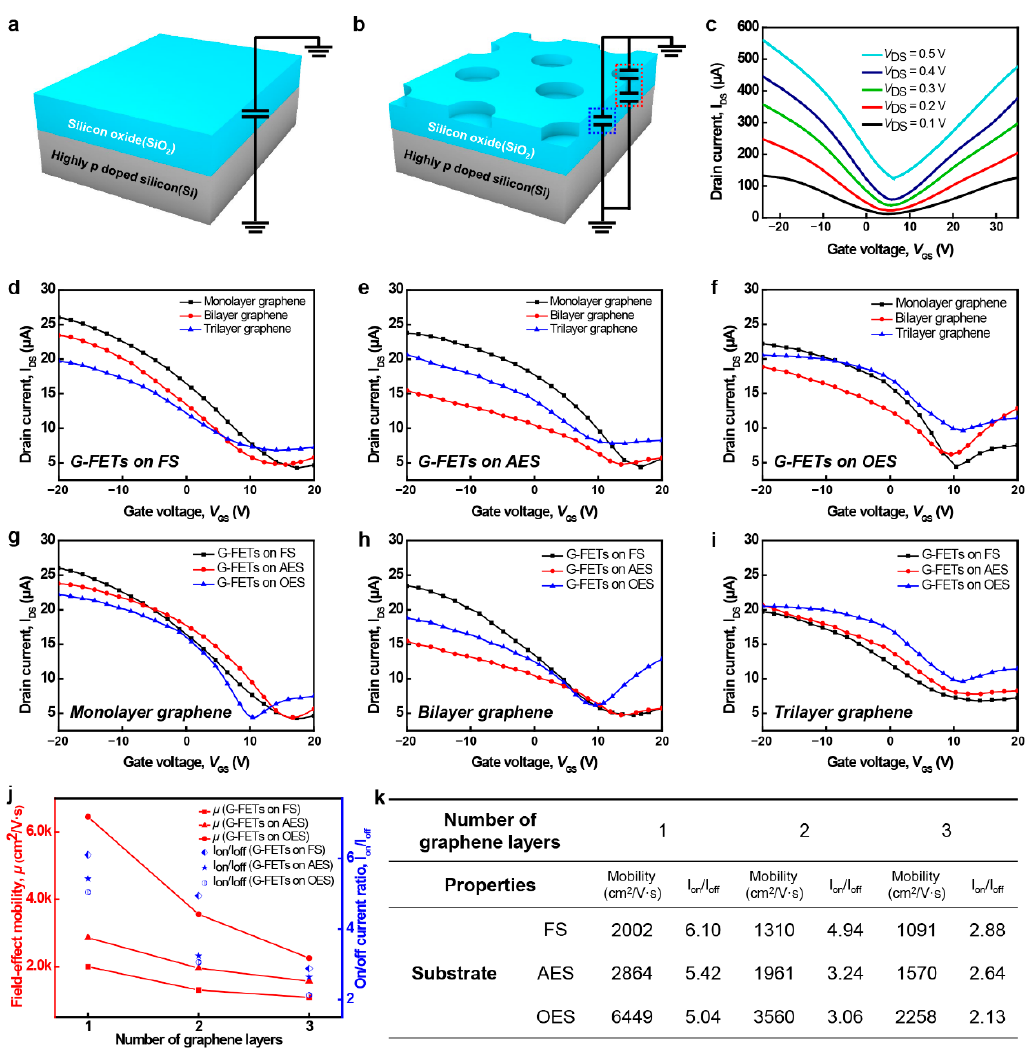
Figure 4. The schematic illustration of the cross-sectional dielectric layers along with their equivalent capacitor circuits for the ( a ) FS and ( b ) nanopatterned substrates (AES and OES). ( c ) Transfer curves of monolayer G-FETs on OES for different values of V DS (V DS = 0.1~0.5 V, internal = 0.1 V). ( d – i ) Transfer curves of G-FETs with different number of graphene layers on various substrates. ( j , k ) Field-effect mobility ( µ ) and on/off current ratio of G-FETs vs. number of graphene layers on various